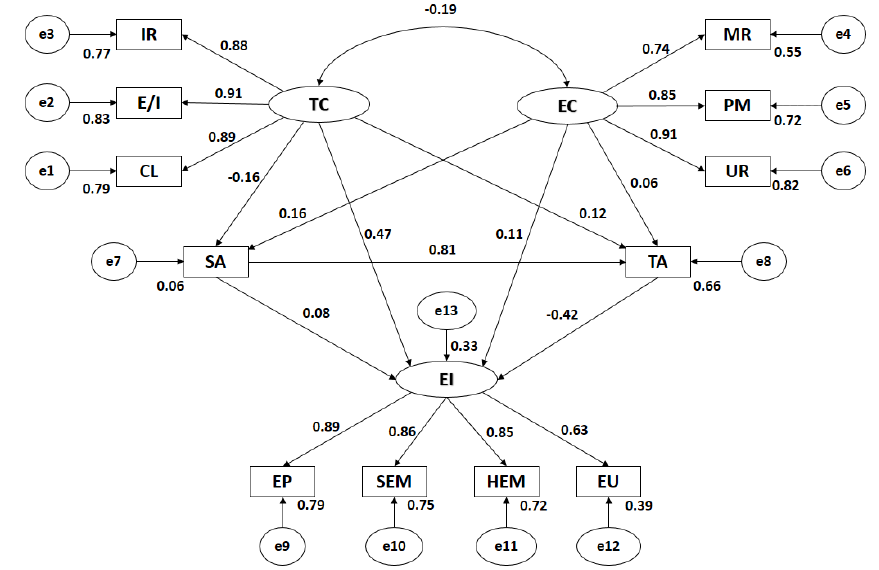
Figure 2. Structural equation modelling in individual sports. Note: TC, Task Climate; CL, Cooperative Learning ; E/I, Effort/Improvement; IR, Important Role; EC, Ego Climate; MR, Member Rivalry; PM, Punishment for Mistakes; UR, Unequal Recognition; SA, State Anxiety; TA, Trait Anxiety; EI, Emotional Intelligence; HEM, Heteroemotional Management; SEM, Self ‐ emotional management; EP, Emotion Perception; EU, Emotion Utilisation. Table 1. Structural model in individual sports.